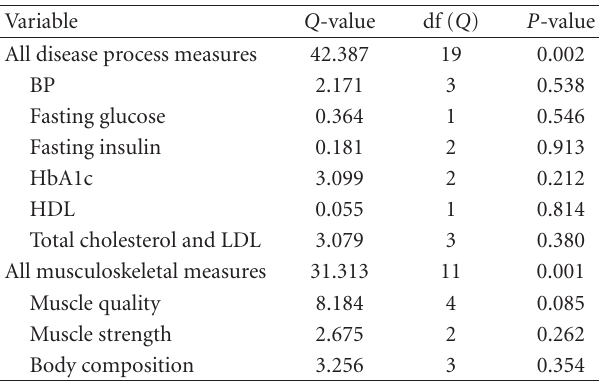
Table 4: Heterogeneity for moderator